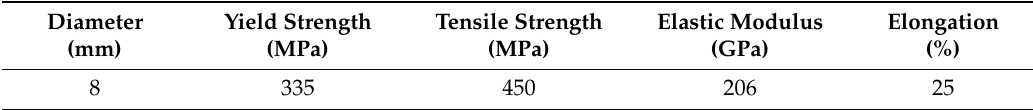
Table 4. Dimensions of composite slab specimens.